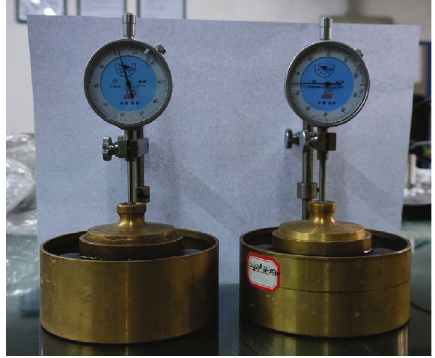
Figure 3: The dilatometer.